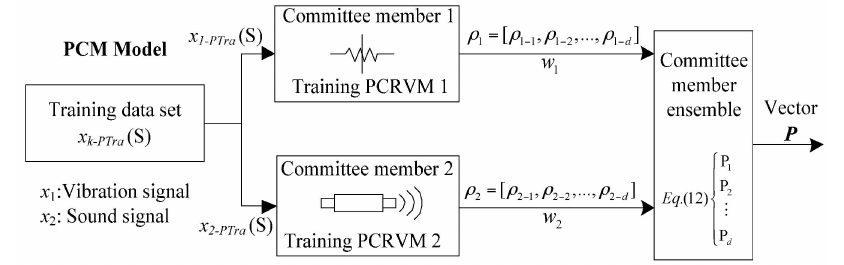
Figure 4. Procedure for training probabilistic committee